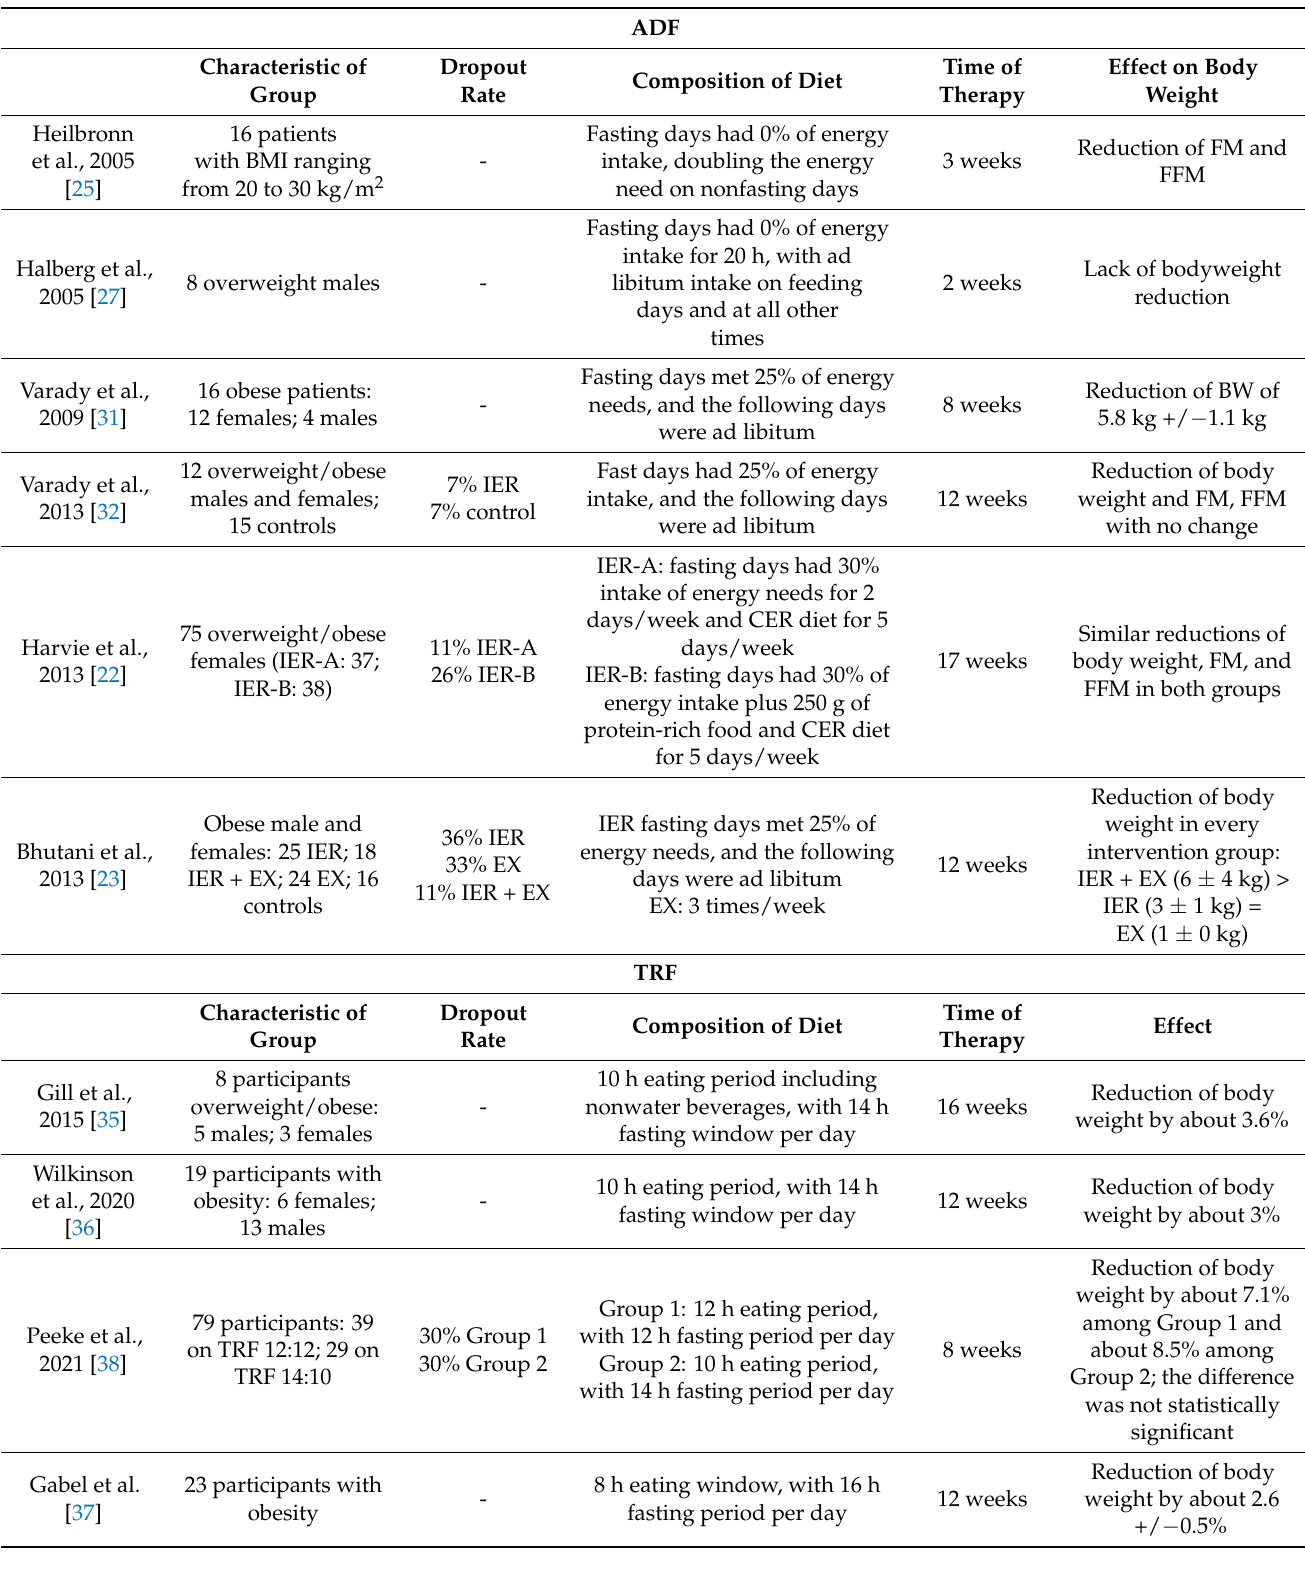
Table 1. Characteristics of included studies on body weight changes among patients on diets based on intermittent energy restriction (IER) such as alternate-day fasting (ADF) and time-restricted feeding